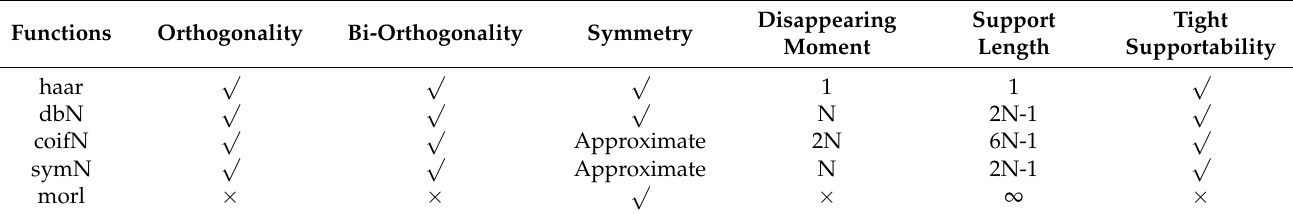
Table 1. Features of several different wavelet basis functions.